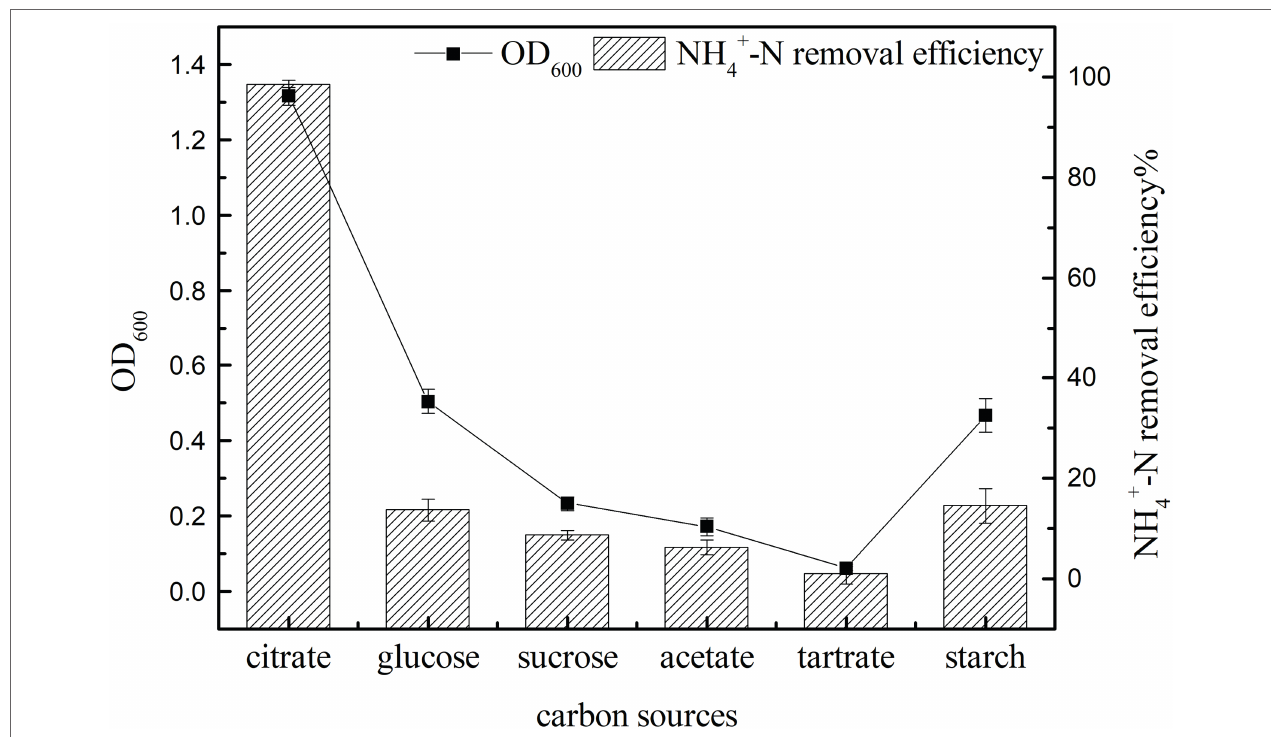
FIGURE 4 | Effect of carbon source on the growth and ammonia nitrogen removal efficiency of strain K17. The mixture was cultured at 165 rpm and 30 ° C for 12 h.